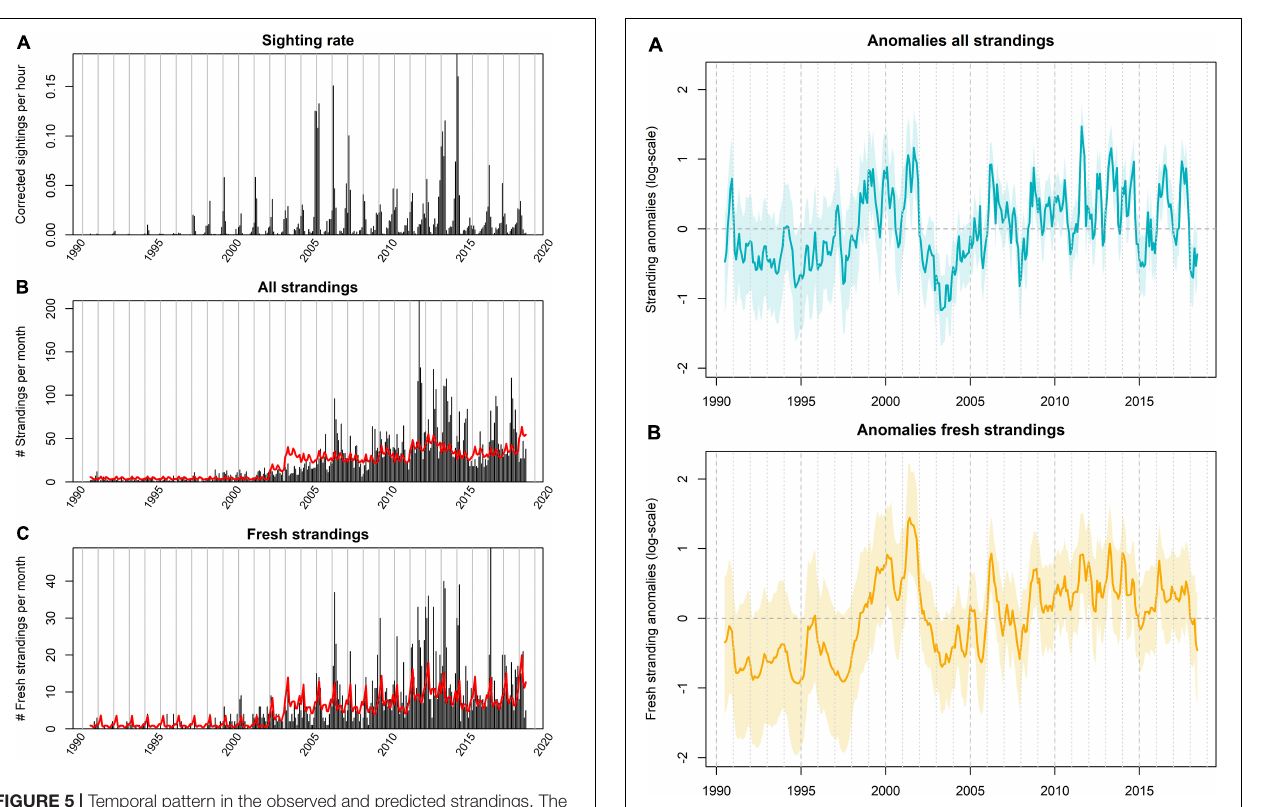
FIGURE 6 | Residual pattern between the observed and expected porpoise strandings (based on the sightings) as captured by the temporal correlation structure (A) . Values are on log-scale. Peak values (above the mean of 0) imply more porpoise strandings than expected and low values (below the mean of 0) imply less strandings than expected. A fairly similar pattern was observed for the fresh and alive strandings, although this showed a closer resemblance between the observed and expected strandings (B)